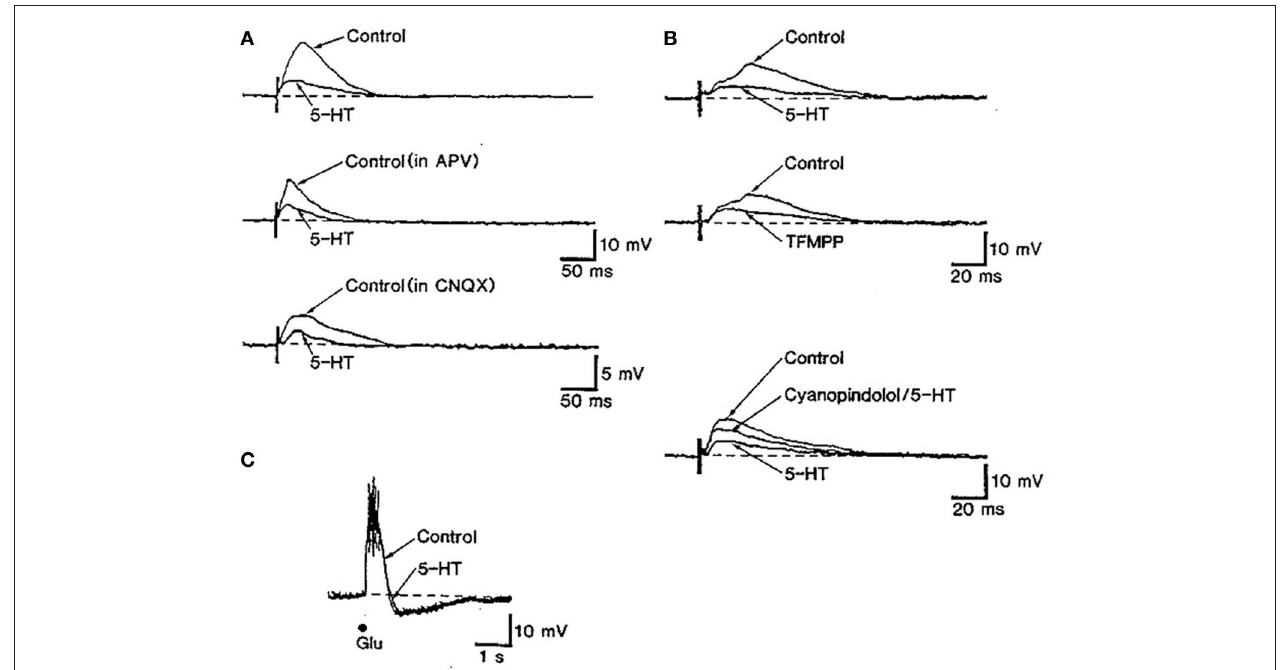
FIGURE 4 | The stimulation of 5-HT 1B receptors inhibits excitatory synaptic transmission in rat cingulate cortex. (A) The stimulation of subcortical white matter elicited excitatory postsynaptic synaptic potentials (EPSP) dependent on NMDA and non-NMDA currents in in cingulate cortex pyramidal neurons. The action of 5-HT partially depressed EPSPs. (B) The reduction of EPSPs by 5-HT was